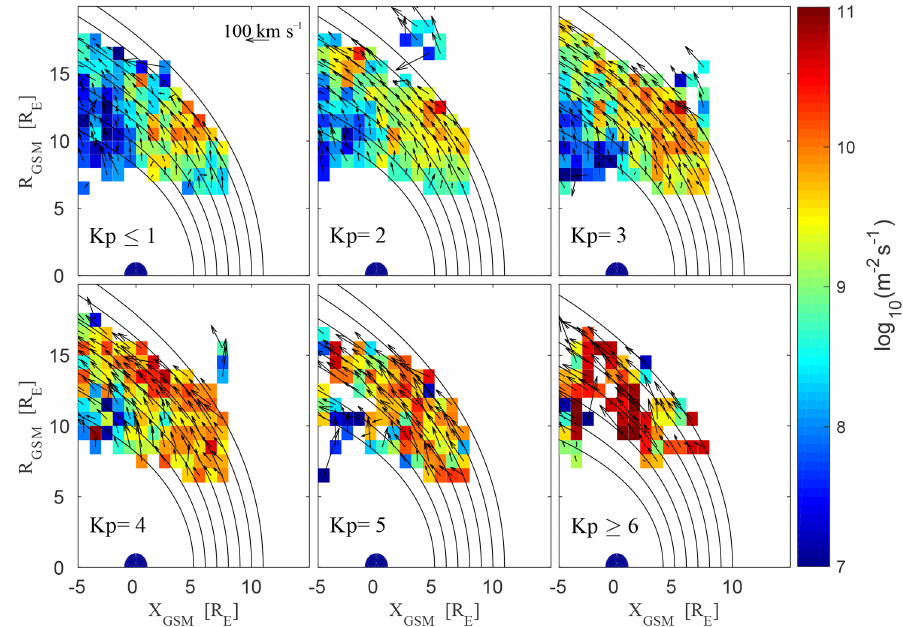
Figure 6. The spatial distribution of plasma mantle O + flux in cylindrical coordinates, ( X gse , R gse = (Y 2 gse + Z 2 gse ) 1 / 2 ), for periods of different geomagnetic conditions: Kp = (0, 1), Kp = 2, Kp = 3, Kp = 4, Kp = 5, and Kp = (6, 7, 8). The colour bar defines the average flux intensity, and the arrows represent the average O + bulk